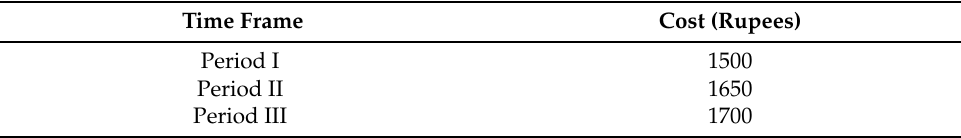
Table A7. Transportation cost for full truck without uncertainty.